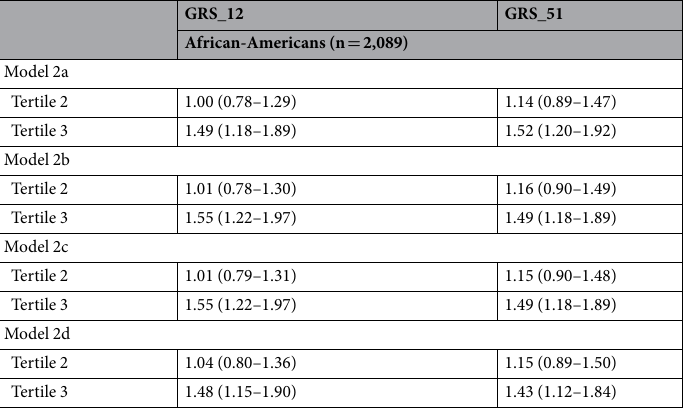
Table 2. Association between genetic risk scores (GRSs) and incident CHD among GERA minority subjects. CHD denotes coronary heart disease; Table entries are hazard ratios (95% CI); See Statistical Methods for explanation of Models 1a-1d and 2a-2d